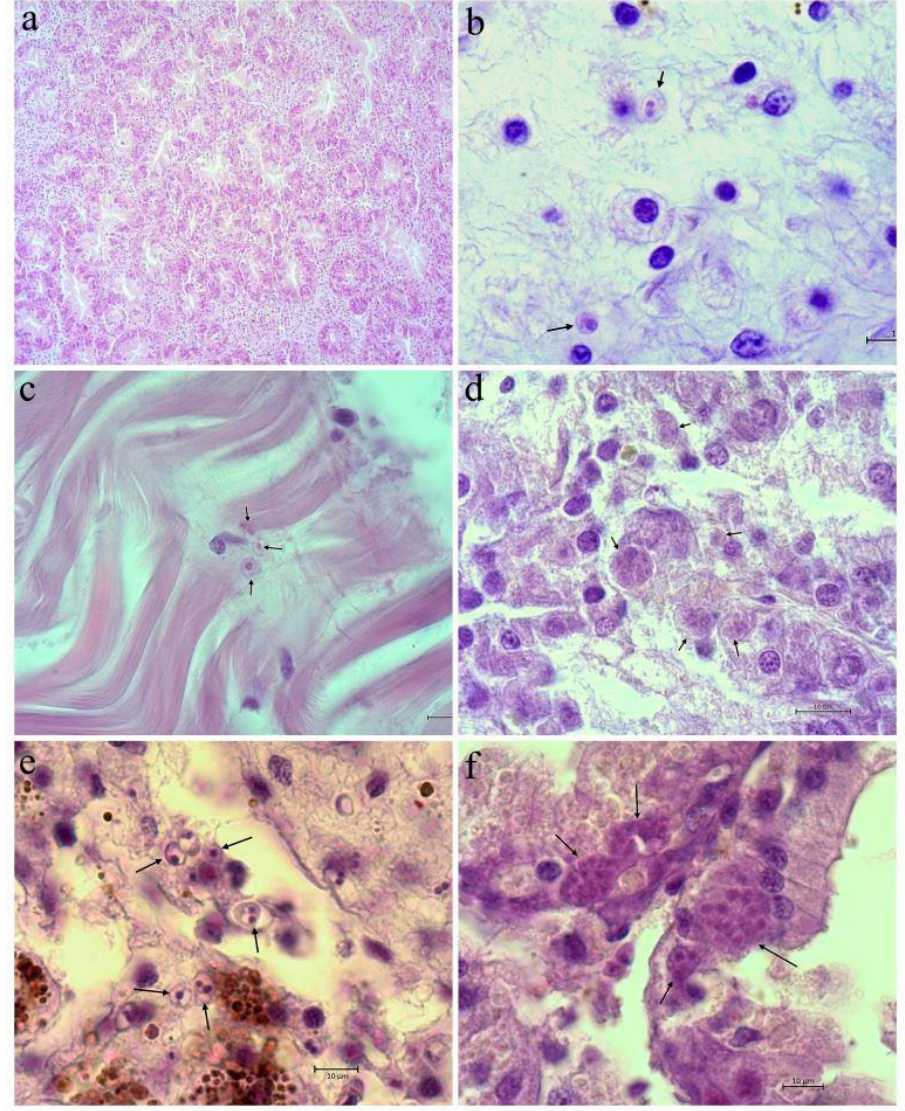
Figure 7. Histological findings in the organs of noble pen shells: Moderate infiltration of hemocytes into the connective tissue of the digestive gland ( a ); uni- and binucleate cells of H. pinnae in the connective tissue of the mantle ( b ); uninucleate cells of H. pinnae in the muscle ( c ); uninucleate cells and plasmodia in the connective tissue of the digestive gland ( d ); intra-hemocytic stages of uninucleate cells in the connective tissue of the digestive gland ( e ); sporulation stages of H. pinnae in the epithelium of the digestive gland with a disruption of the digestive tubules ( f ).